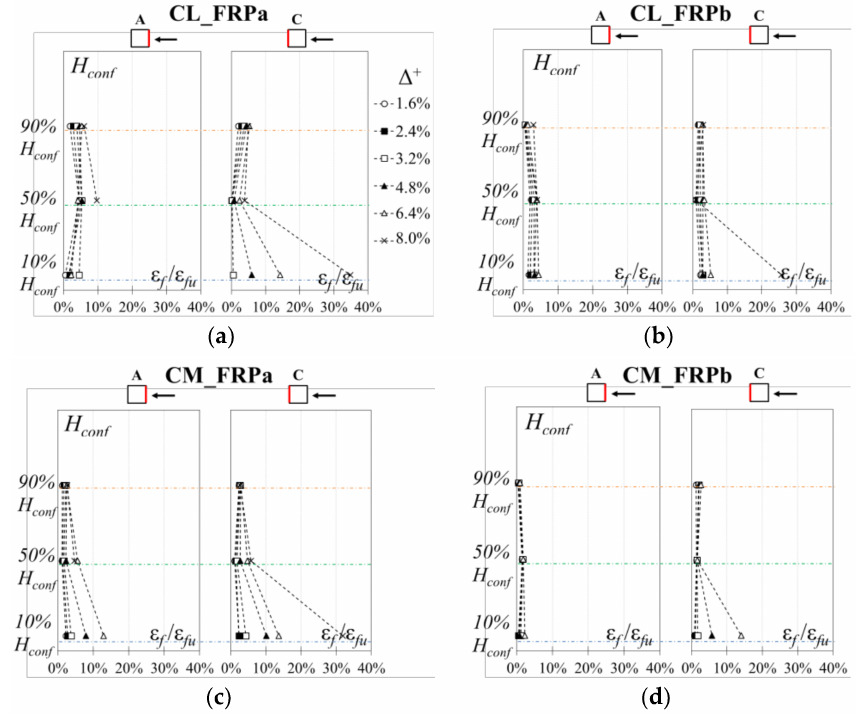
Figure 13. Vertical CFRP axial strain profiles: ( a ) CL_FRPa; ( b ) CL_FRPb; ( c ) CM_FRPa; ( d ) CM_FRPb.